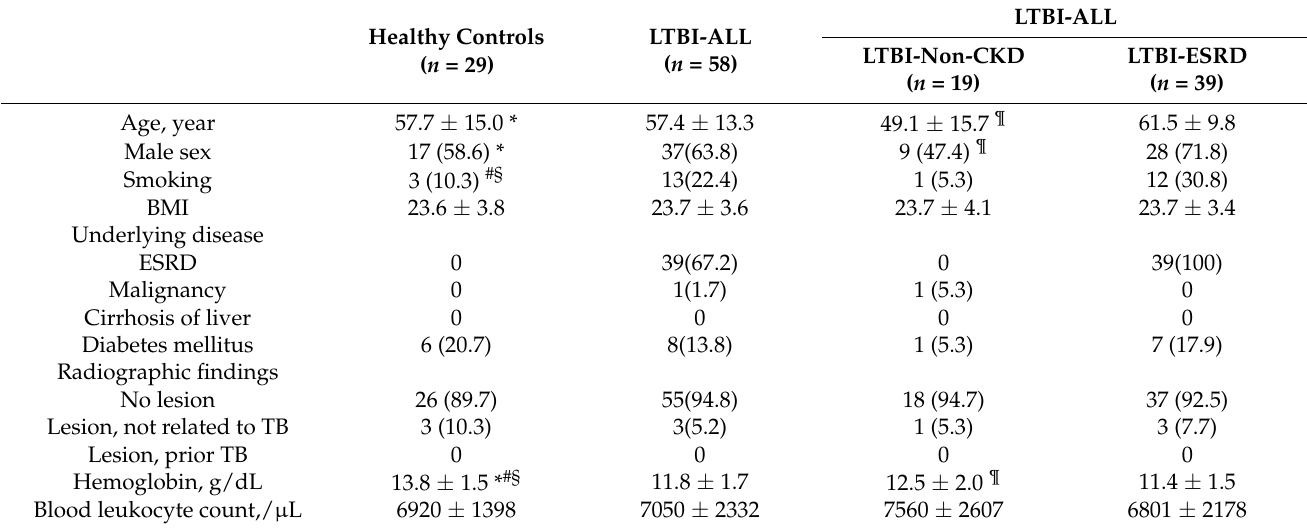
Table 1. Demographic data of the enrolled